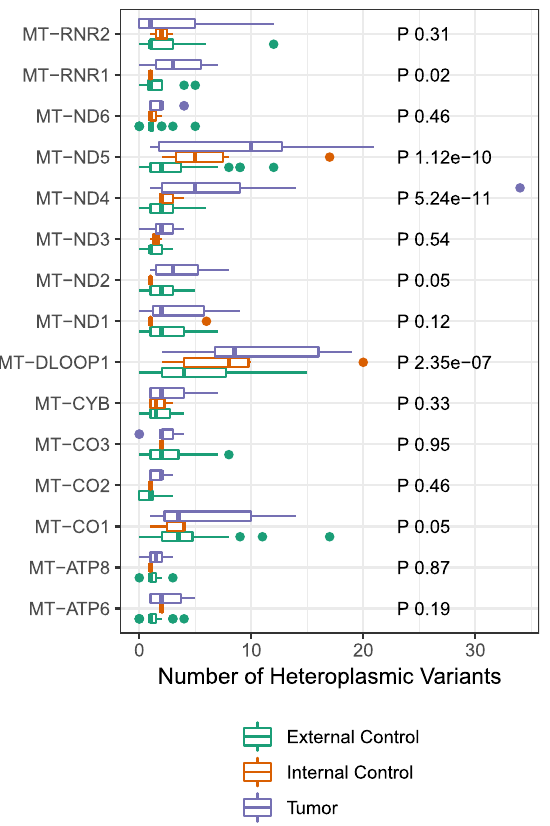
Figure 5. Joined comparison of all three groups regarding mitochondrial genes with heteroplasmic variants, with the respective p-value obtained with Poisson regression.